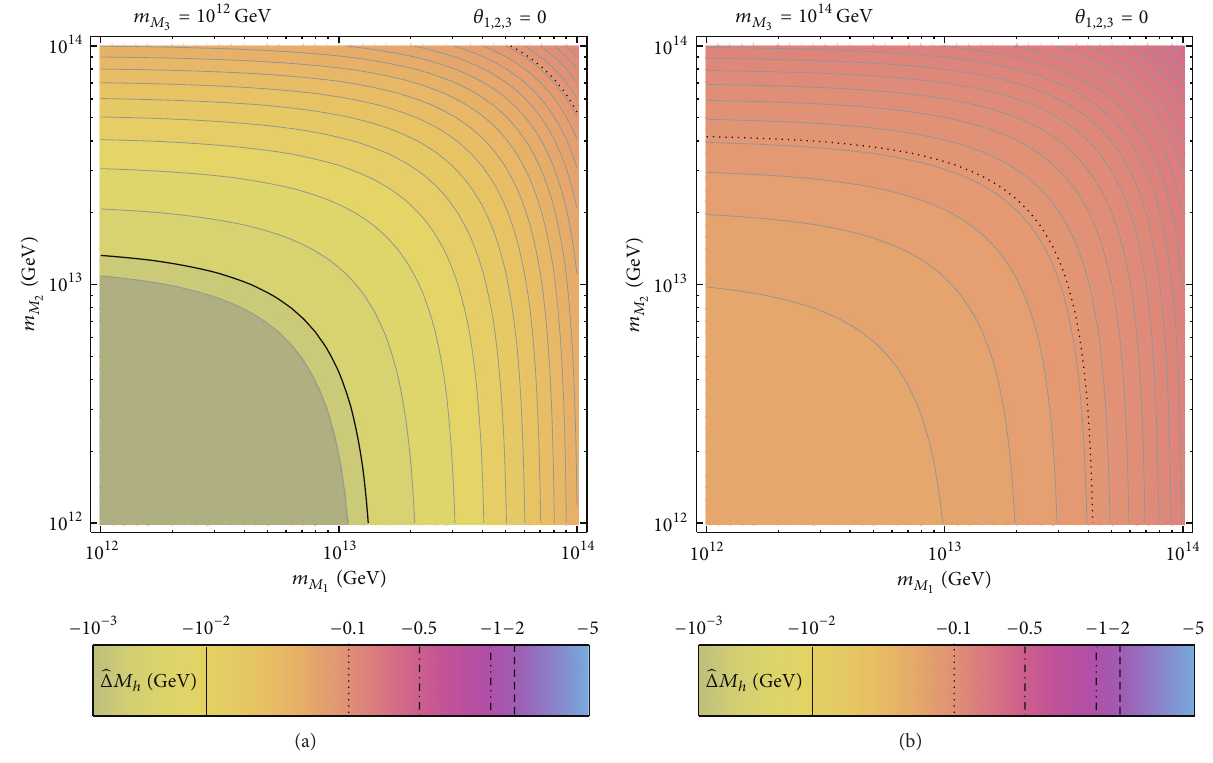
̂Δ𝑀 Figure 9: ℎ as a function of 10 14 GeV. The rest of input parameters are set to the reference values in